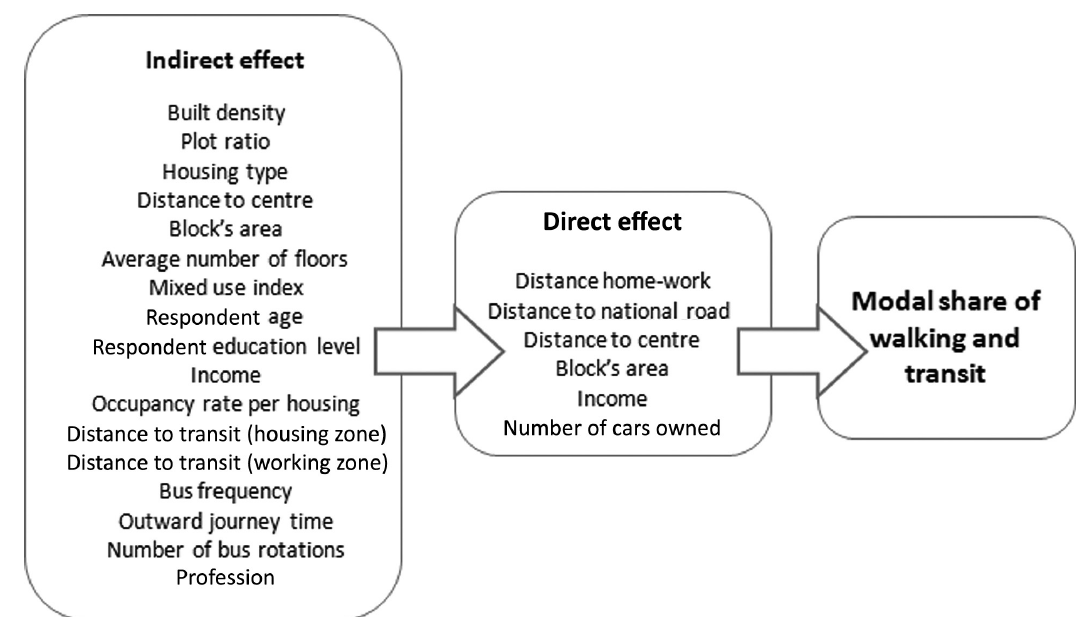
fig. 11. Hypothetical causal pathways between variables and the modal share of walking and